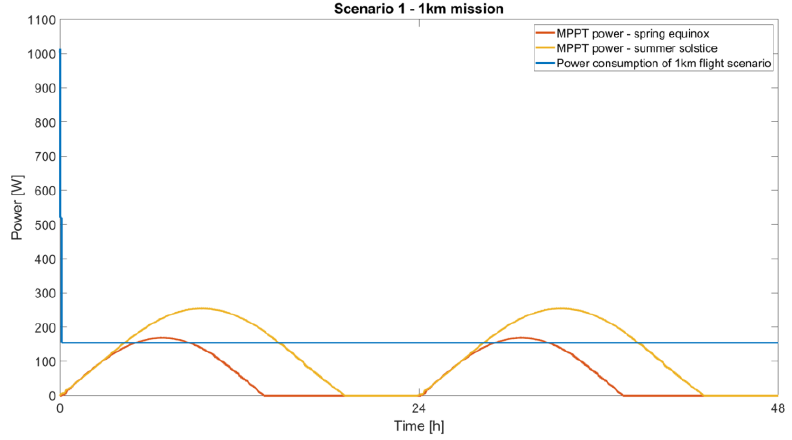
Figure 11. Power consumption and MPPT power produced by solar cells for 1st scenario.